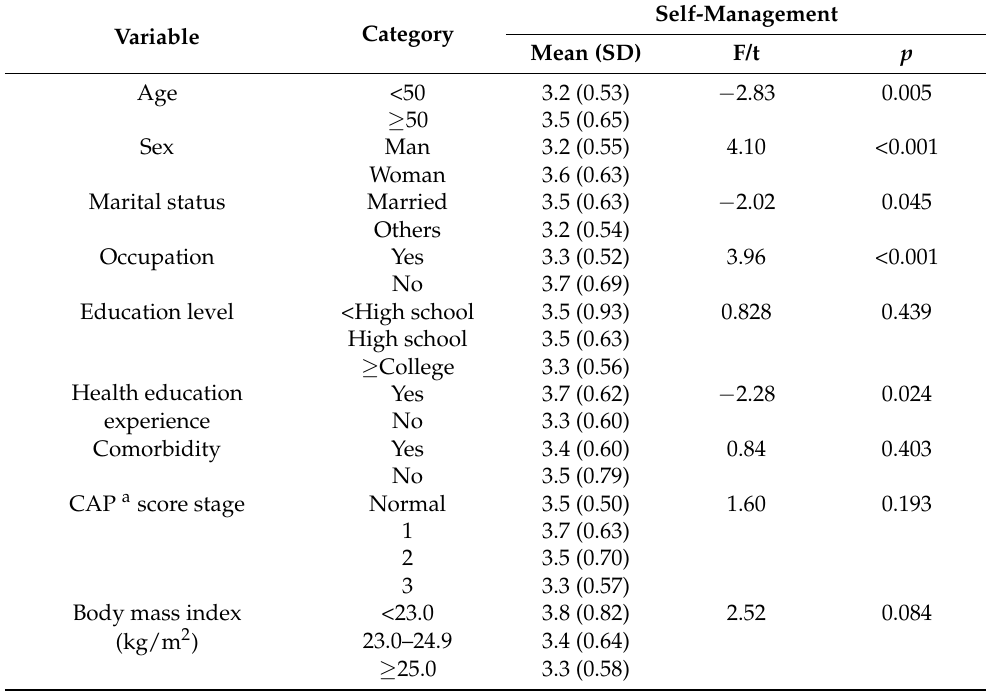
Table 3. Differences in self-management by demographic and disease-related factors ( N = 150).